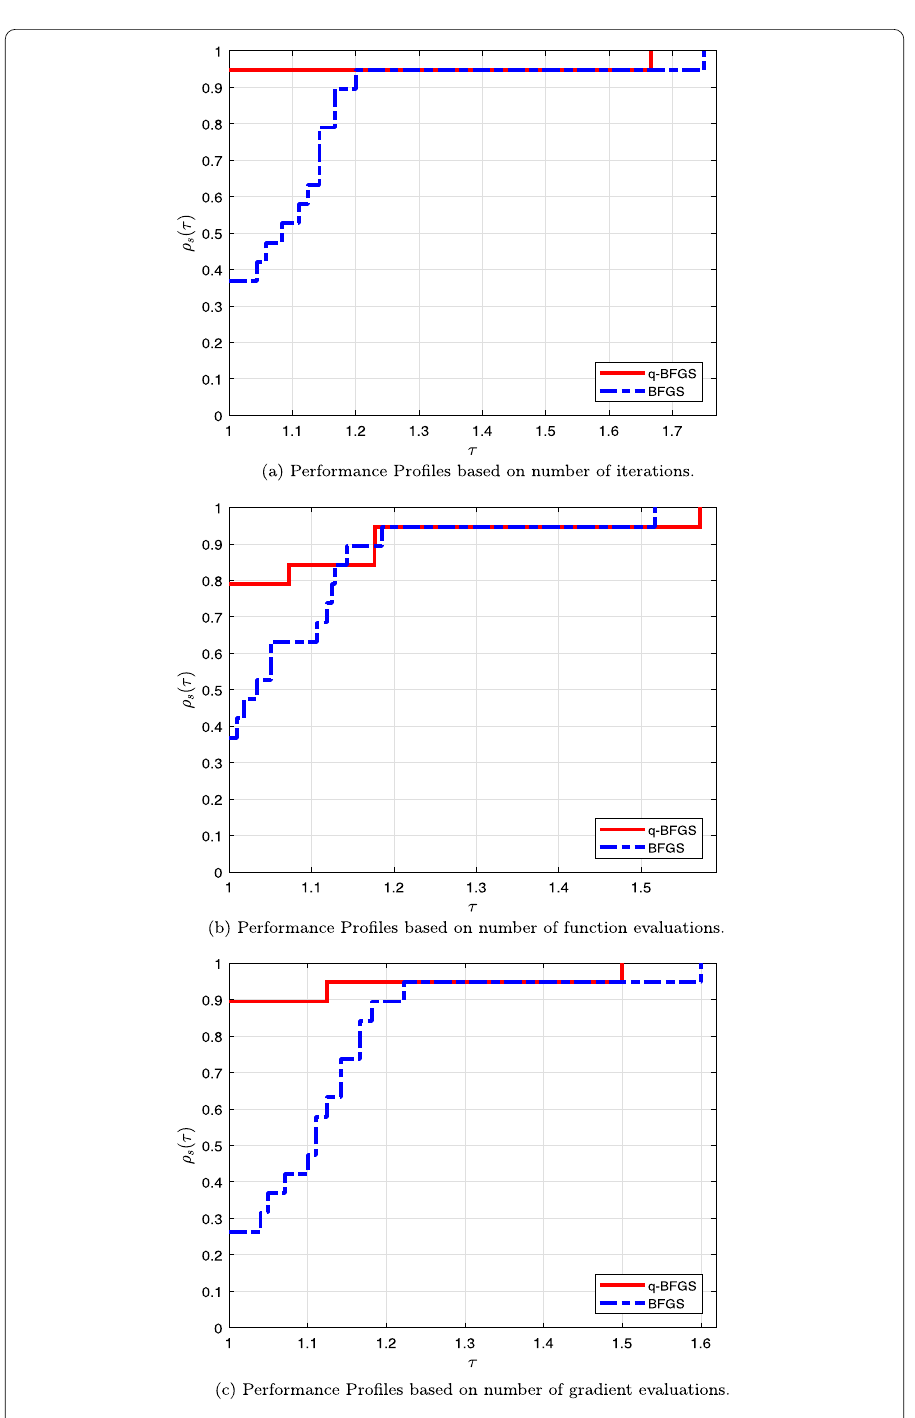
Figure 7 Performance profiles based on the number of iterations, the number of function evaluations and the number of gradient evaluations given in Table 7